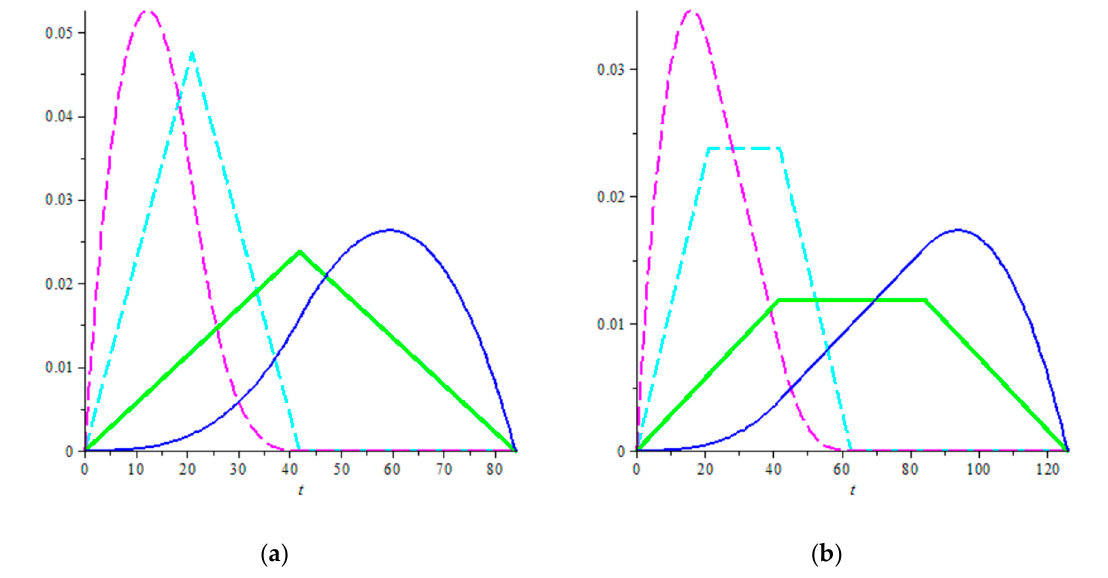
Figure 12. PDFs for travel times of a semi-random trip (cyan dash); a random trip (pink dash); an SC cycle (green solid); and a DC cycle (blue solid) in taxicab geometry: ( a ) in a square-in-time zone with T x = T y = 21 s ; ( b ) in a zone with T x = 2 T y = 42 s .